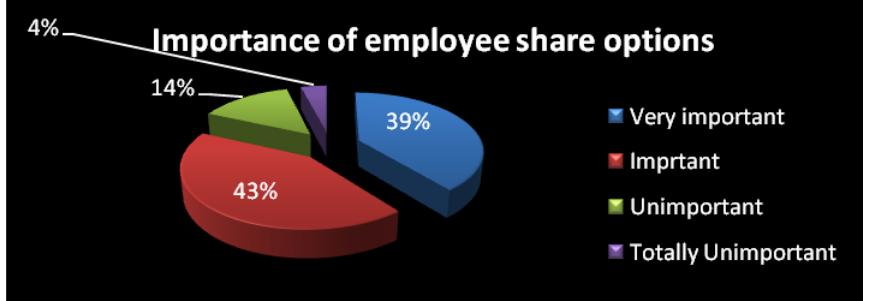
Figure 3. Perceived Importance of ESO